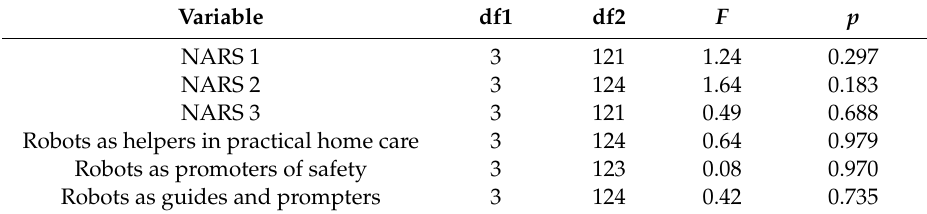
Table 5. Di ff erences between localities in the control group. One-way analysis of variance.